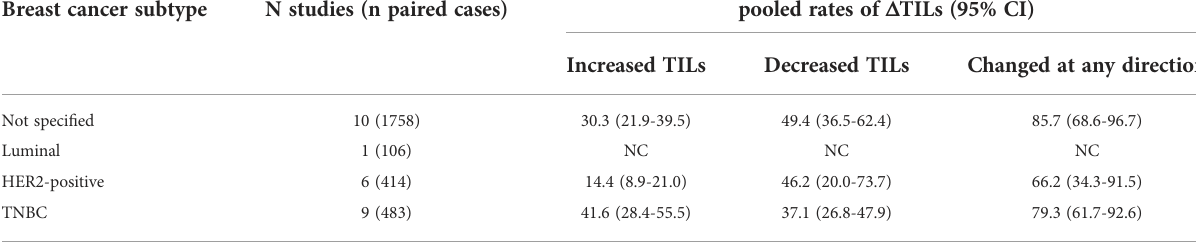
TABLE 3 Pooled rates of D TILs before and after NAT in matched-paired tissue samples in early breast cancer patients. Breast cancer subtype